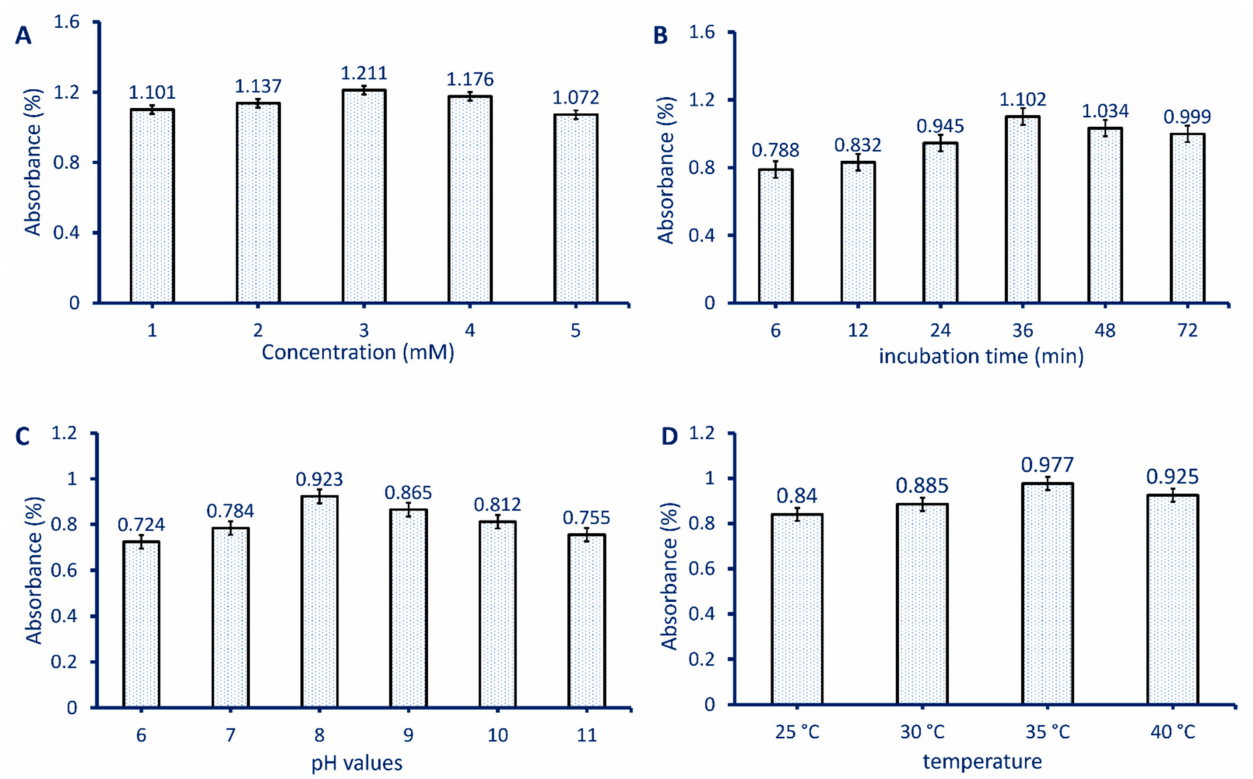
Figure 3. Optimizing factors for biogenic MgO-NPs using A. terreus strain S1. ( A ) denotes the different Mg(NO 3 ) 2 · 6H 2 O concentrations; ( B ) denotes the contact time between biomass filtrate and optimum Mg(NO 3 ) 2 · 6H 2 O concentration; ( C ) illustrates the effect of pH values, and ( D ) denotes the effect of incubation temperature on biogenic